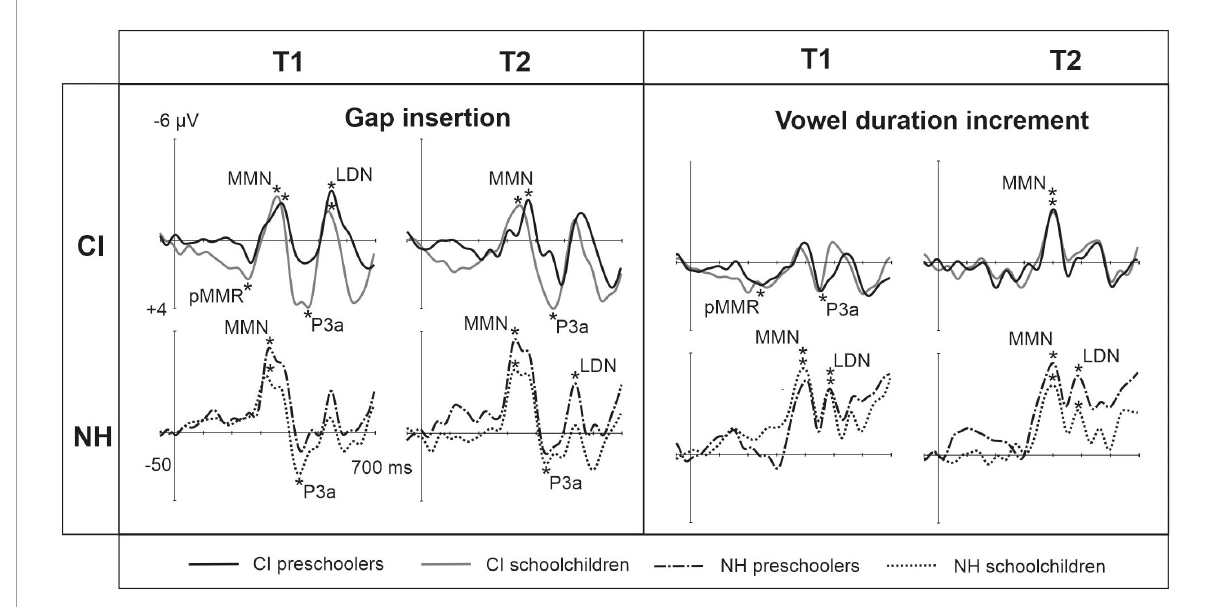
FIGURE1 Difference waveforms (ERPs of deviant minus standard) from the six-electrode ROI (F3, Fz, F4, C3, Cz, C4) for the easy-to-detect change types of gap insertion and vowel duration at measurement time points T1 and T2 for the preschoolers (age below 6 years 9 months) and schoolchildren (age above 6 years and 9 months) with CI and NH. The data is referenced to the nose. Significant responses are marked with an asterisk. ERP, event related potentials; CI, children with cochlear implants; NH, normally hearing children; PR, preschoolers; SC, schoolchildren;